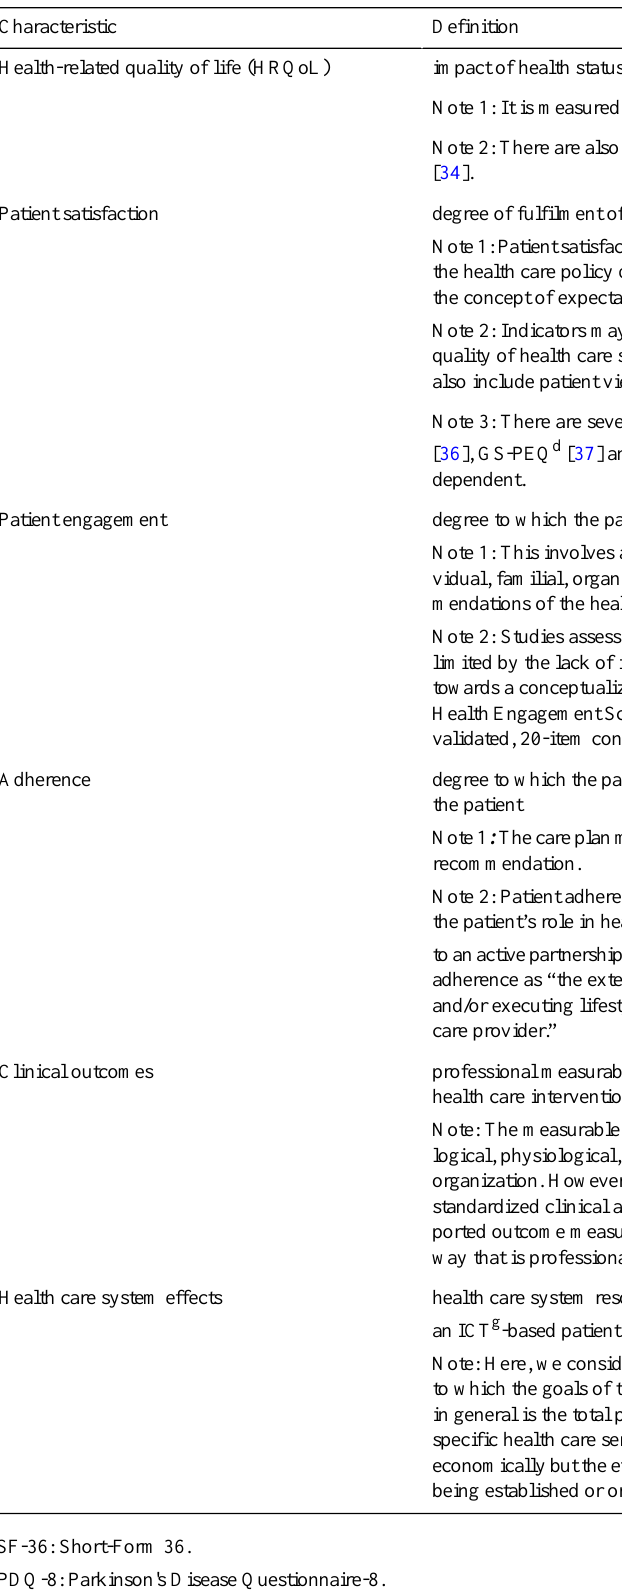
Table 2. Characteristics of empowerment